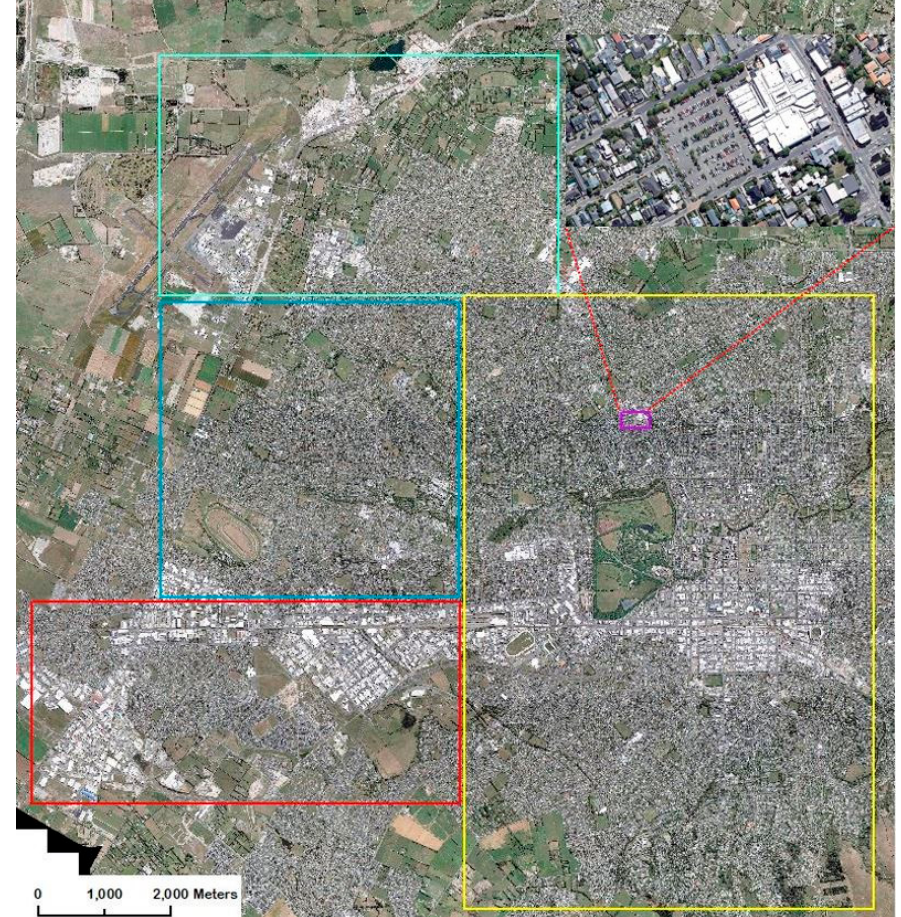
Figure 6. The five sub-datasets in the WHU building dataset with 0.2 m GSD (ground sampling distance). The red box is the main study area with images of 2011 (TA-2011) and 2016 (TA-2016) for evaluating change detection. The yellow box contains images of 2016 (SC-2016) to train the building extraction model for 2016. The green box contains images of 2011 to train the building extraction model for 2011. In the blue box, we simulate changed building samples automatically upon existing building masks of 2016 (SI-2016) to train the building change detection model. Table 1. Details of the sub-datasets in the WHU building change detection dataset.